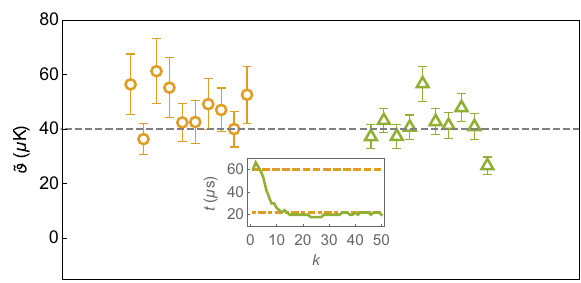
FIG. 6. A priori optimized protocol versus adaptive protocol. Comparison between the a priori optimized (orange rhombs) and fully adaptive (green squares) protocols. Ten independent runs of the deep-trap experiment are simulated for each method. All parameters are the same as in Fig. 3(b), except for θ min , which is set here to 0.5% of the trap depth U 0 / k B (see Sec. IV E). The inset shows the optimal expansion time as a function of k for one of the simulated measurement records (solid green). The a priori optimal recapture time for this wider hypothesis support is indicated by the orange dashed line. In contrast, the a priori optimal time for the narrower support used in Figs. 1–5 is the orange dash-dot line. Our observation that the a priori optimized method seems to perform equally well than the arguably superior fully adaptive scheme is explained by the fact that, for the nar- rower prior, t s almost coincides with the true optimum for most of the